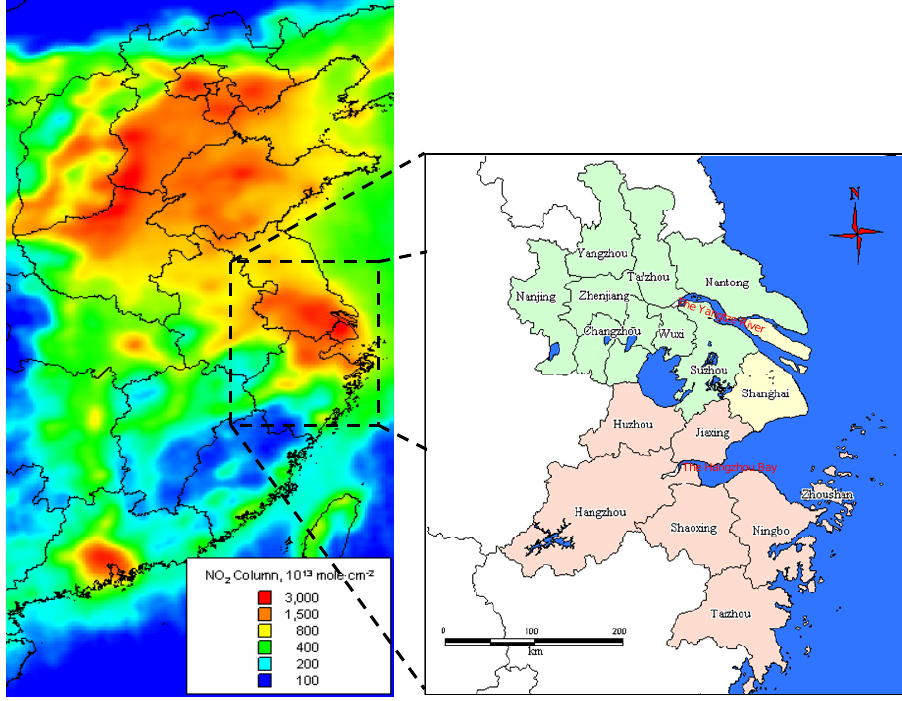
Fig. 1. Satellite observed tropospheric NO 2 concentration in 2007 (left) and research domain of the YRD region (right).